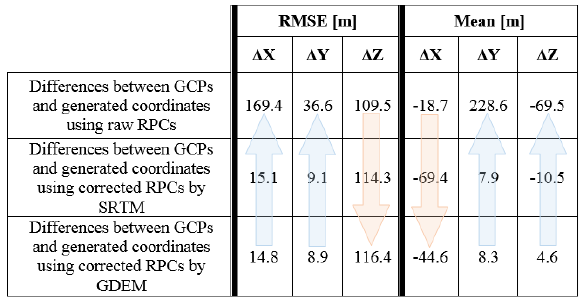
Table3. The results of RPC